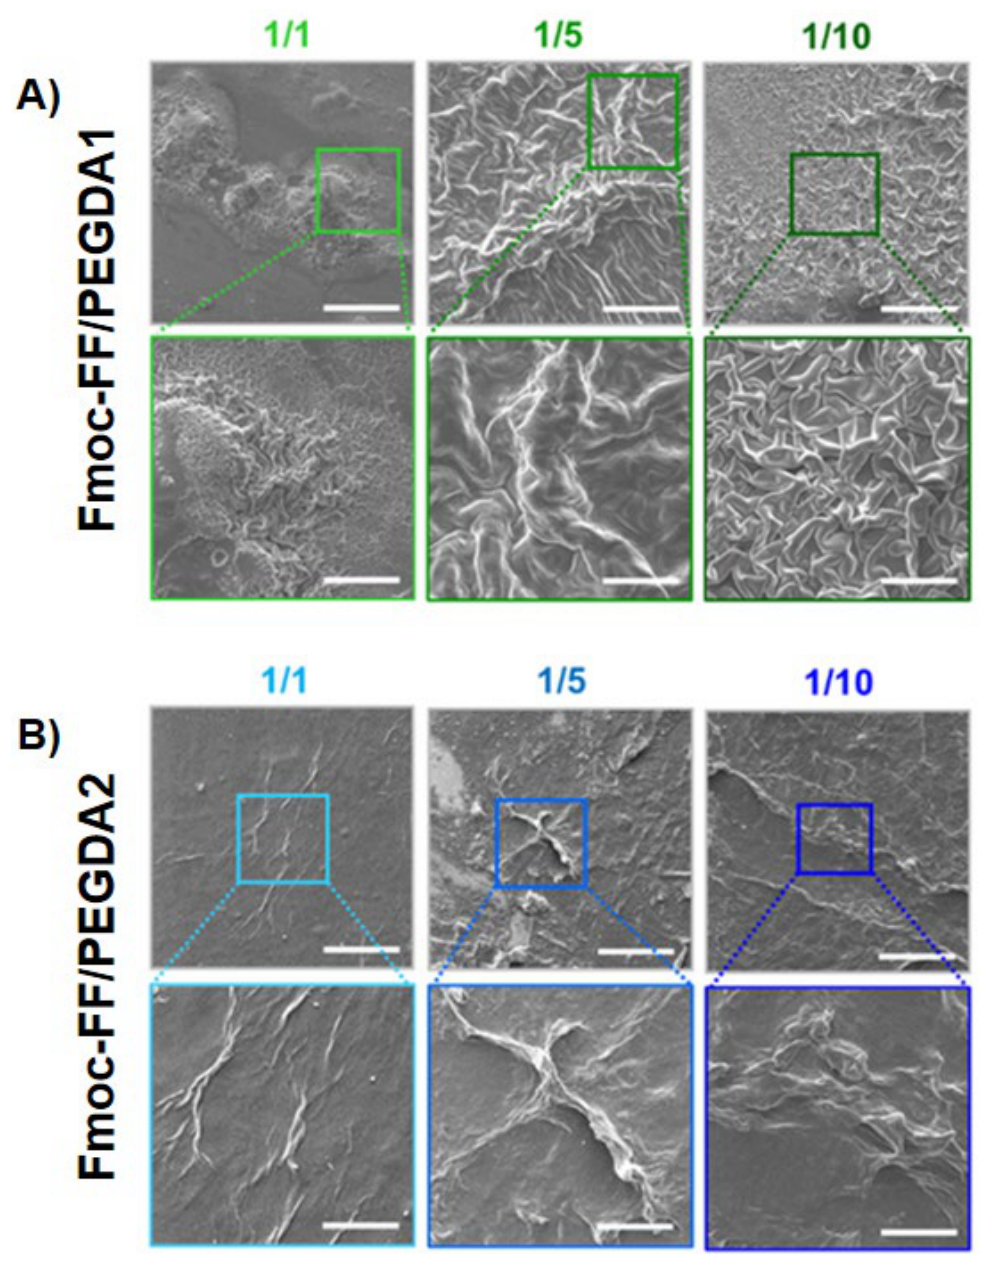
Figure 6. Selected microphotos of mixed xerogels of PEGDA1 ( A ) and PEGDA2 ( B ) series. Scale bar = 100 µm and 30 µm.